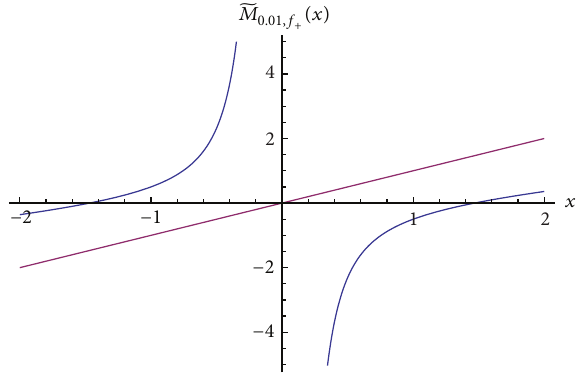
Figure 5: Graphics of = [0.470144 ⋅⋅ ⋅ ,0.529856 ⋅ ⋅⋅ ] . 𝐼 0.25